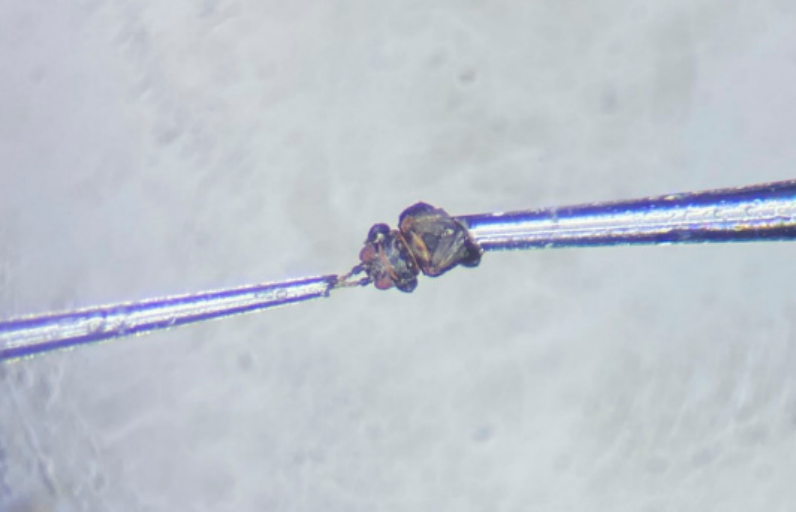
Figure 1. Antenna connection mode of Dendrothrips minowai in electroantennogram (EAG) trials.